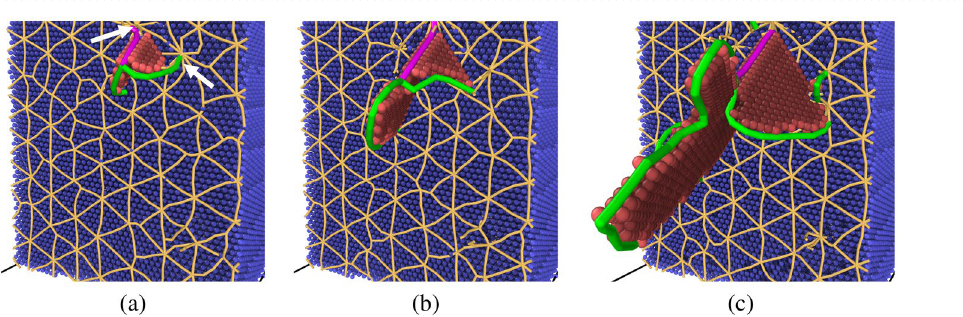
Figure 6. Snapshots of the bicrystal with (cid:31) 111 [111] STGB at a nominal tensile strain of (a) ǫ = 6.1% , (b) ǫ = 6.2% , and (c) ǫ = 6.3% depicting the initial stages of 1/6 (cid:31) 112 (cid:30) dislocation (green line) nucleation from the GB leaving behind a stacking fault (atoms in red). The orange lines represent the GB dislocation network and atoms in only one half of the bicrystal system are shown in blue for a better visualization of the defect